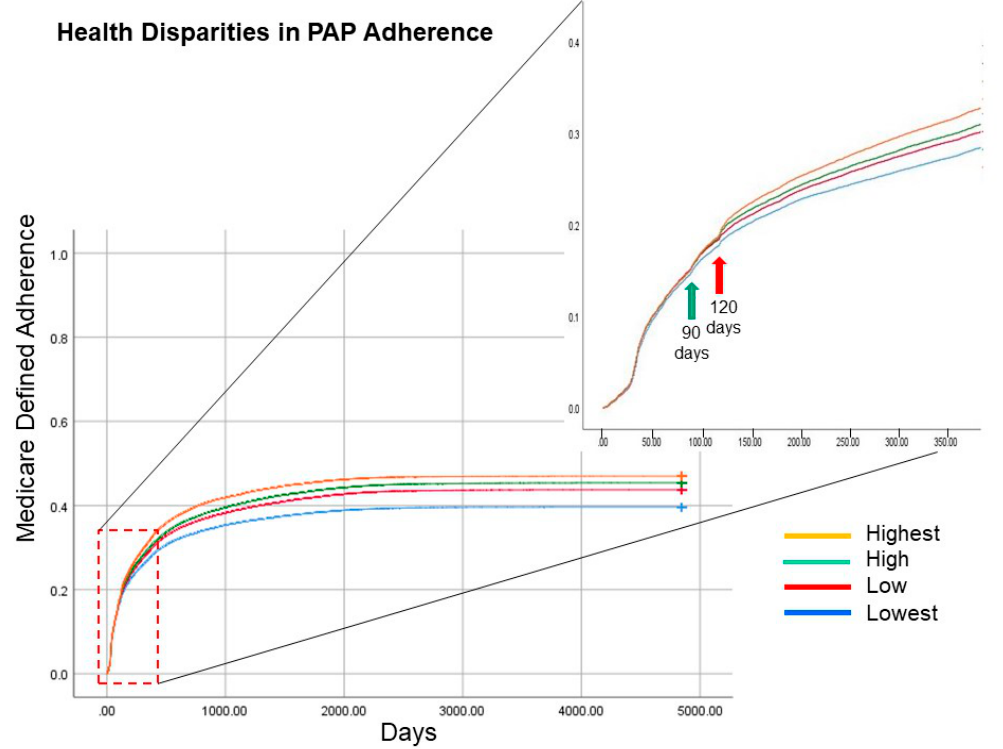
Figure 3. Kaplan–Meir curves of time to achieve Medicare-defined adherence to positive airway pressure (PAP) therapy device are shown for various income quartiles. Note that individuals from higher income neighborhoods are more likely to become adherent by Medicare-defined criteria sooner in time and also a greater proportion of individuals from a higher income neighborhood are likely to be adherent to PAP therapy (Log Rank test, p < 0.0001). The inset reveals a distinct pattern of emergent differences at the 90-day and again at the 120-day timepoints suggesting an effect of the 90-day Medicare rule that threatens to discontinue benefits in individuals who are nonadherent at that point in time (difference-in-difference analysis; p < 0.0001).